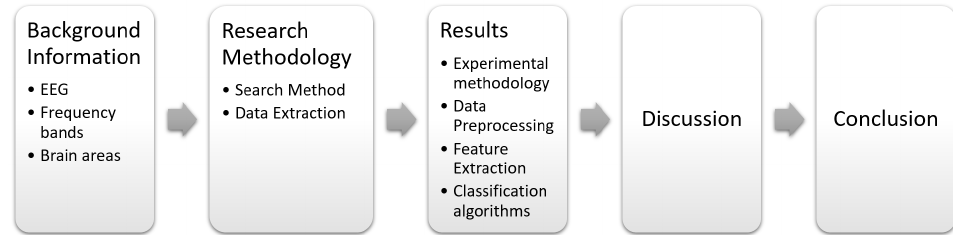
Figure 1. Structure of this study. It includes: A background on brain and electroencephalogram fundamentals; the proposed research methodology for searching and data extraction steps; results for the experimental methodology and the pattern recognition stages; discussion about the findings and concluding